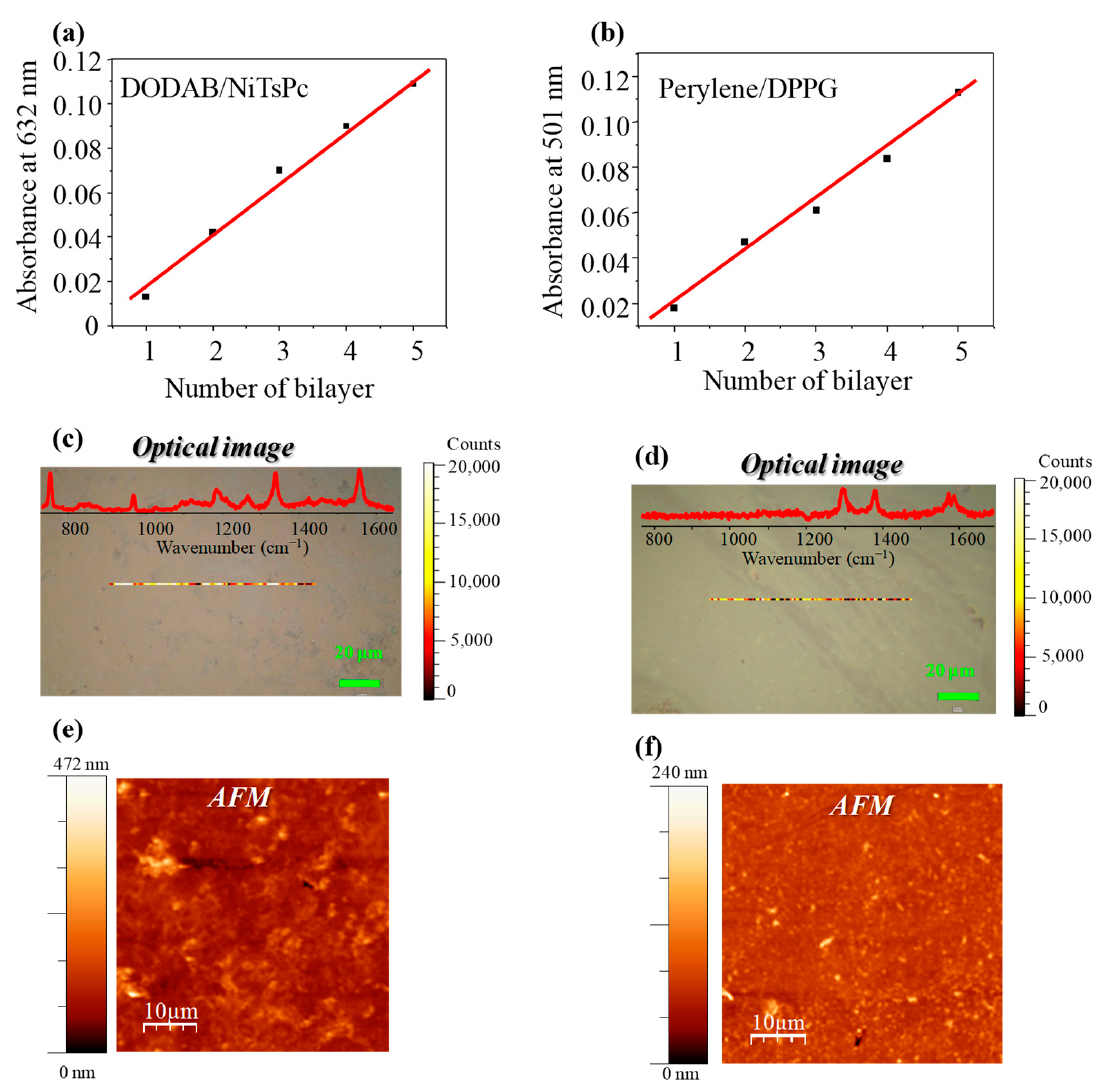
Figure 2. Monitoring LbL film growth by absorbance versus number of bilayers for ( a ) DODAB/NiTsPc and ( b ) Perylene/DPPG. Optical images and chemical mapping of ( c ) (DODAB/NiTsPc) 5 and ( d ) (Perylene/DPPG) 5 LbL films with the Raman spectra of LbL films as inset. Topography AFM images for ( e ) (DODAB/NiTsPc) 5 and ( f ) (Perylene/DPPG) 5 on glass substrates.